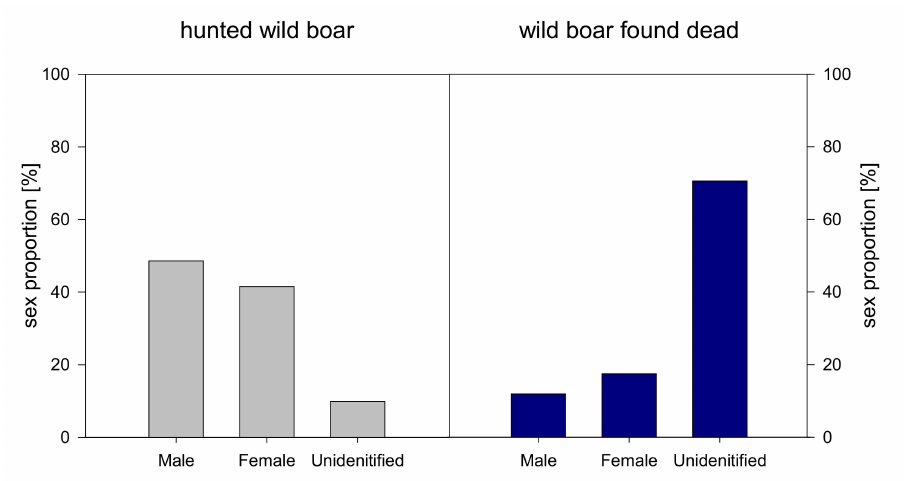
Figure 3. Sex distribution [%] of ASF positive wild boar hunted (grey bars, left side) and found dead (blue bars, right side) during 2014–2018 (cases of all years have been accumulated).